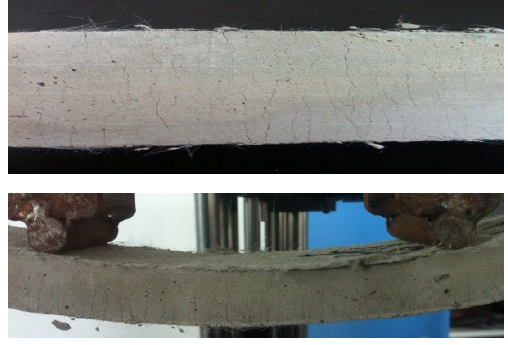
Figure 13. Typical multiple cracking of specimens.